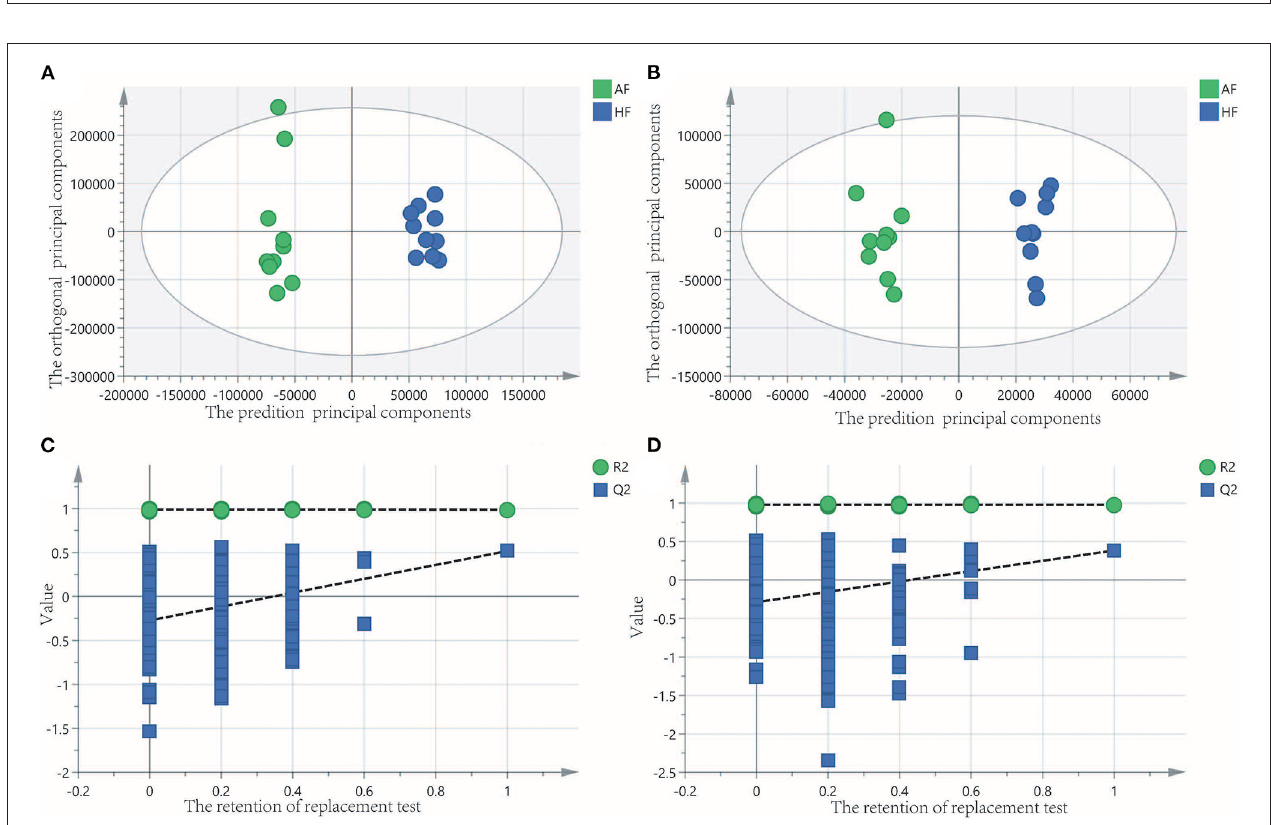
FIGURE 4 | Orthogonal partial least squares discriminant analysis (OPLS-DA) of score and permutation test plot for the healthy follicle (HF) and atretic follicle (AF) groups. (A,C) were in the positive ion mode; (B,D) were in the negative ion mode. The intercept limit of Q2 was calculated by the regression line, which was the plot of Q2 from the permutation test in the OPLS-DA